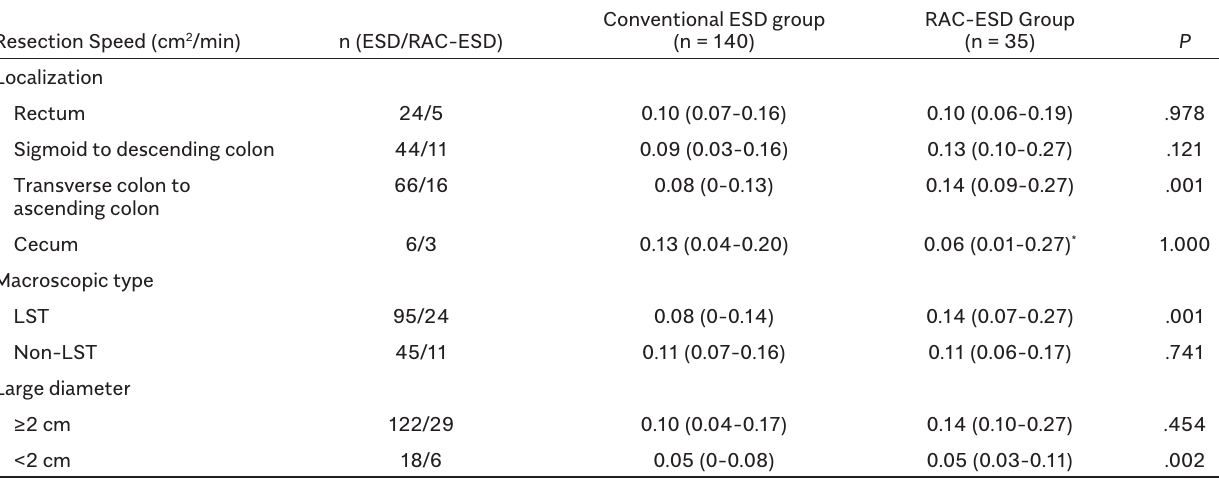
Table 4. Subgroup Analysis of Resection Speed